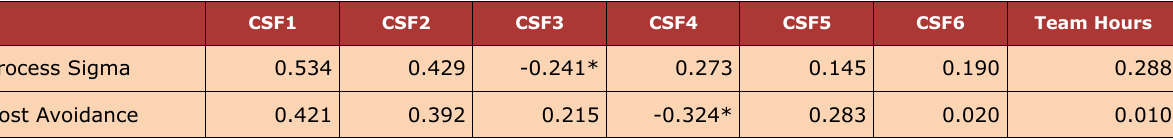
Table 7. Correlation